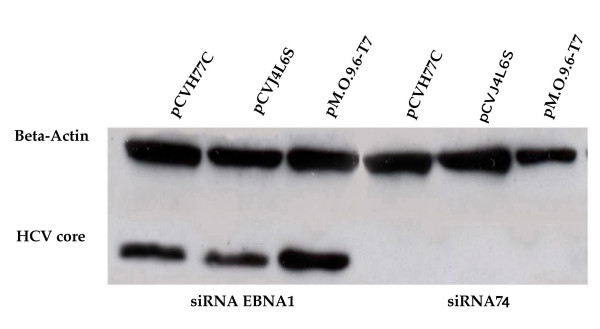
Western blot analysis showing the silencing of core protein from full-length clones of HCV by siRNA transfection. Huh-7 cells were co-transfected with pSuper-retro-siRNA74 and full-length clones of HCV using the FuGENE 6 reagent. After 48 hours, transfected cells were isolated by the treatment with trypsin-EDTA. Cells were washed once with PBS and protein lysates were prepared and electrophoresed on 10% SDS-PAGE gels. The proteins were transferred to nitrocellulose membranes, blocked and immunoreacted with a primary antibody. The membrane was washed and incubated with peroxidase labeled secondary antibody and developed by ECL-chemiluminescence method. siRNA74 inhibited the expression of core protein in the case of all three full-length clones of HCV 1a and 1b. Beta actin levels were used as a control to make sure that equal amount of protein was present in the extracts.